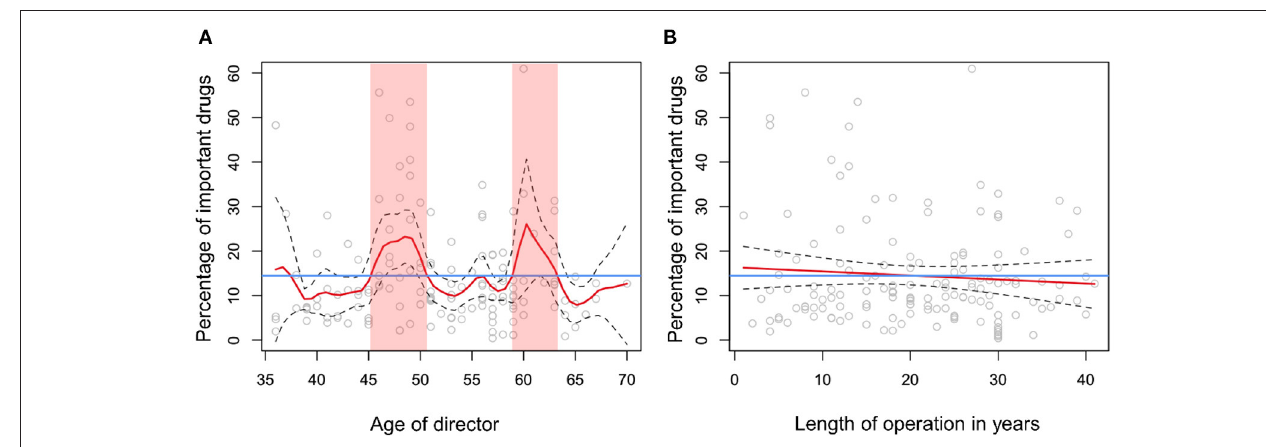
FIGURE 5 | Relationships between the proportion of important drugs among all antimicrobial drugs used and (A) age of the clinic director (years), and (B) years clinic has been in operation. Red lines in panels (A,B) show the fitted non-parametric regression lines. Blue lines in panels (A,B) show the mean percentage of important drugs relative to total usage, 14.2%. Red ribbons in panel (A) indicate the age ranges where percentage of important drugs exceeded the mean value.